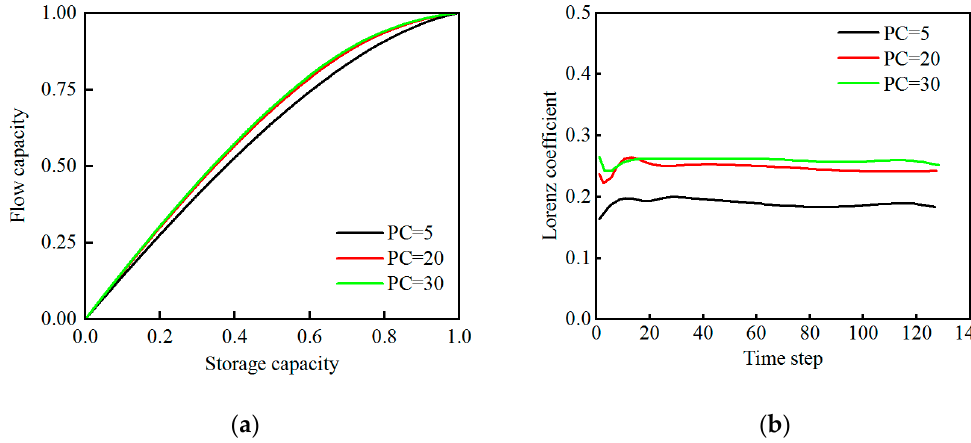
Figure 15. Effect of lateral permeability contrast on the flow heterogeneity. ( a ) Lorenz curve; ( b ) flow heterogeneity curve.